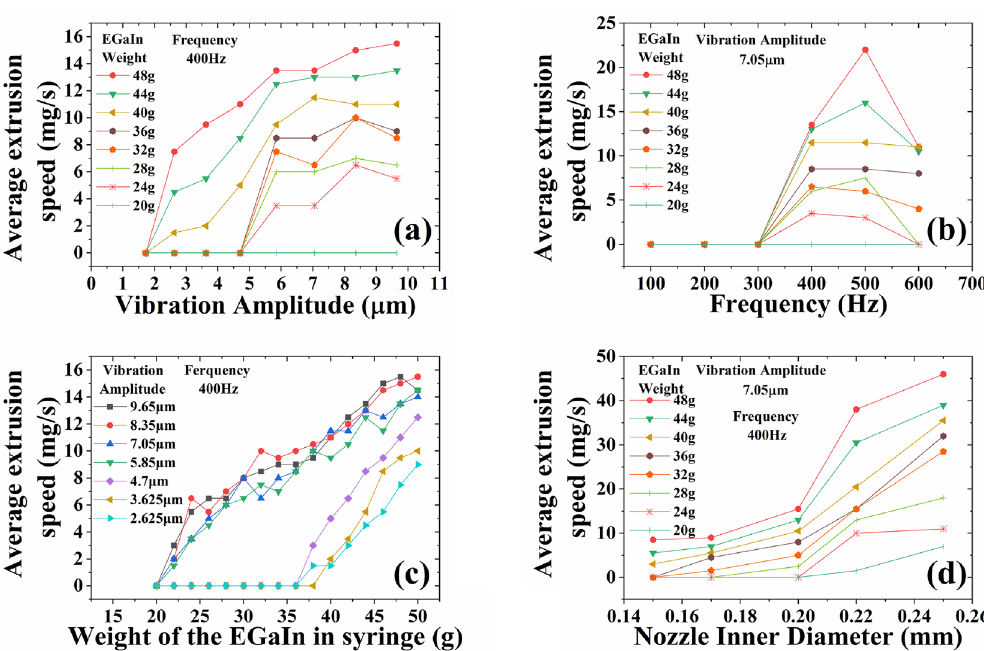
Figure 7. Influence of vibration parameters, weight and nozzle inner diameter on extrusion speed. ( a ) Influence of vibration amplitude on the average extrusion speed. ( b ) Influence of vibration frequency on the average extrusion speed. ( c ) Influence of the weight of the EGaIn in the syringe on the average extrusion speed. ( d ) Influence of different nozzle inner diameters on the average extrusion